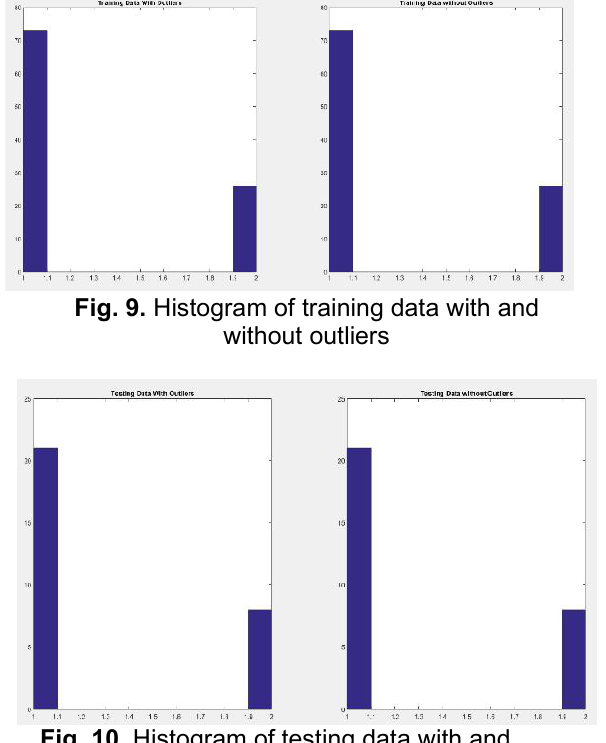
Fig. 10. Histogram of testing data with and without